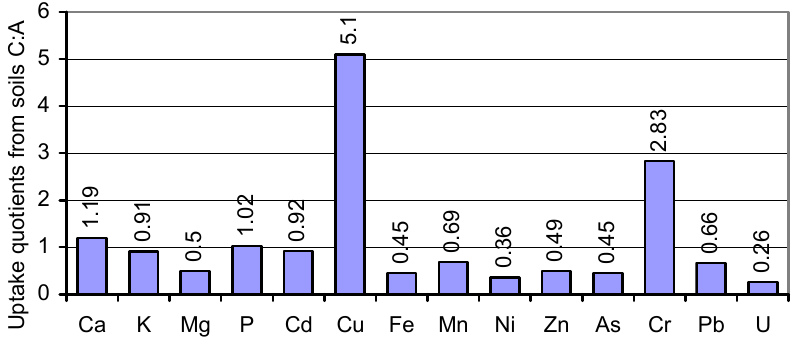
Figure 5. Quotients of the percentages the whole plants (root, shoot, and grains) incorporated from the total soil content of the respective mineral. Values of soil- C grown plants are divided by those of the soil-A grown plants which represent factor 1. Standard deviations range from 6%–13% of the values.